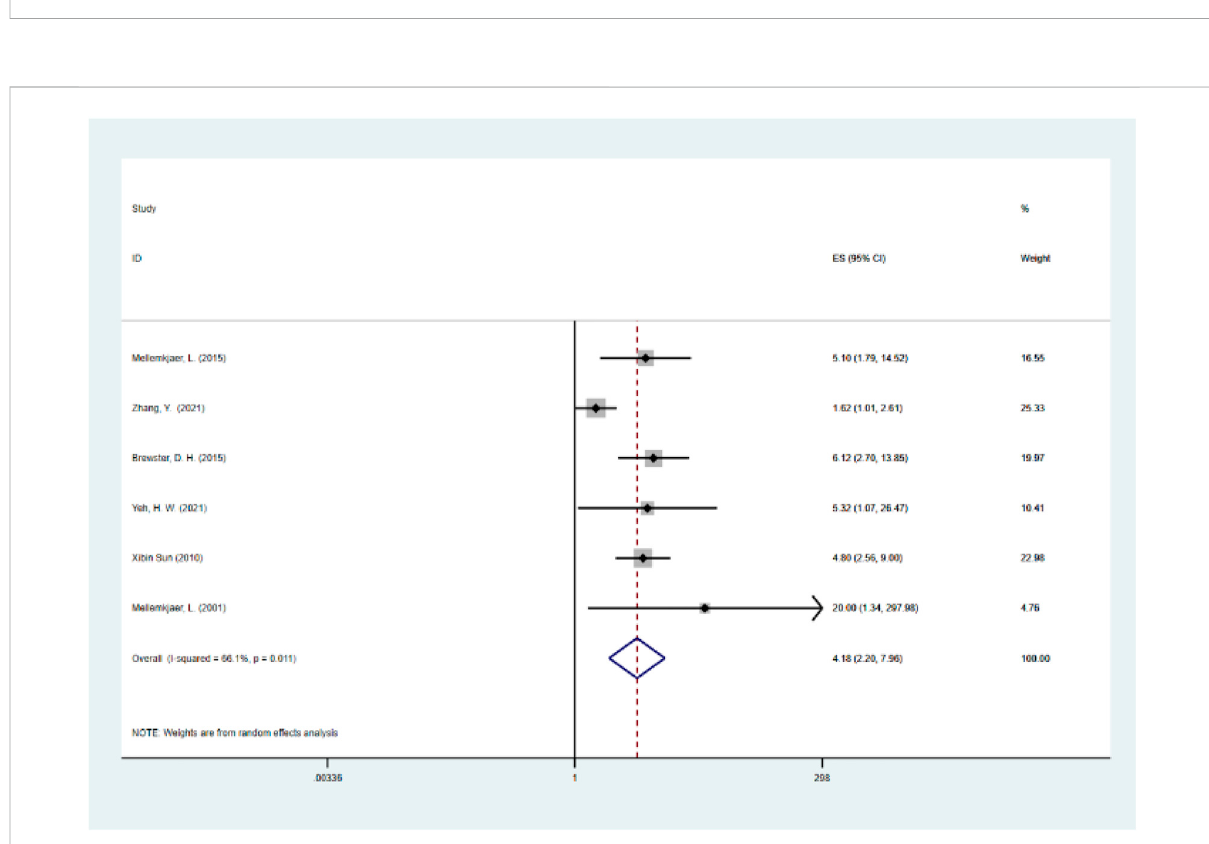
FIGURE 4 Forest plot of irregular diet and the incidence of esophageal